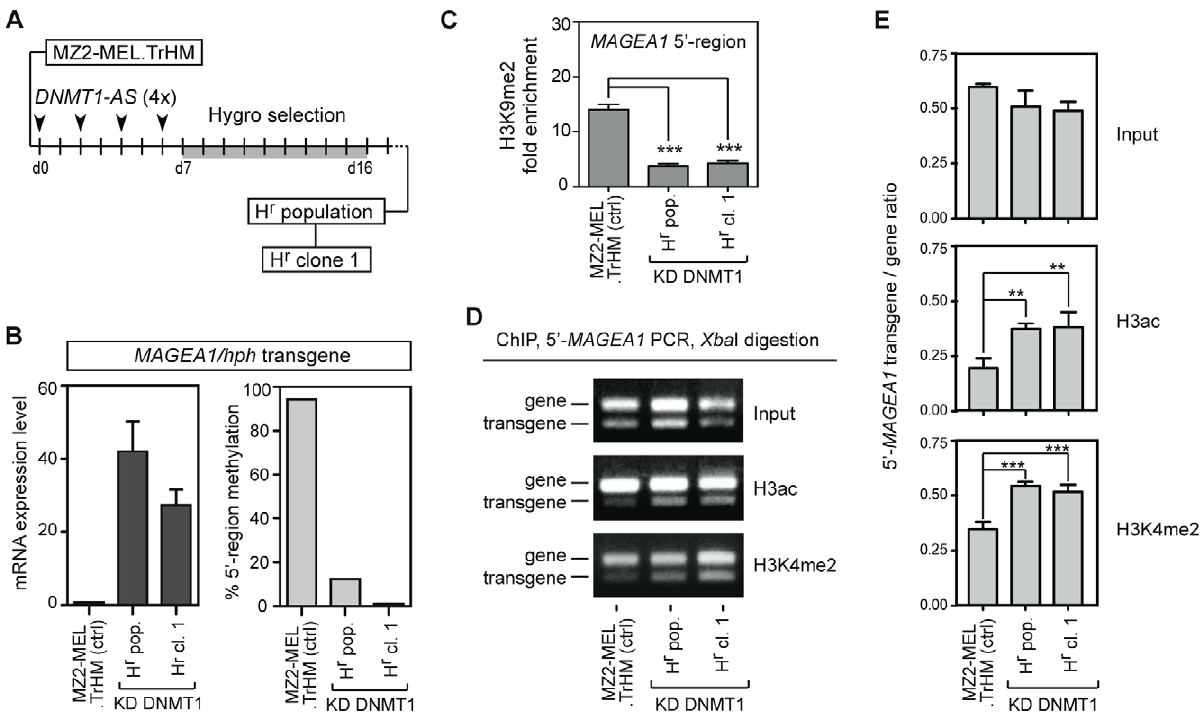
Figure 5. DNA demethylation induces reversal of histone marks in MAGEA1/hph . A , Schematic outline of the derivation of the H r population and H r clone 1 from MZ2-MEL.TrHM cells (see reference [24] for details). MZ2-MEL.TrHM cells were repeatedly tranfected with antisense oligonucleotides directed against DNMT1 ( DNMT1-AS ) during 7 days, and were thereafter transferred into medium containing hygromycin. After 9 days of hygromycin selection, a resistant population emerged (H r population), and a clone (H r clone 1) was isolated from this population by limiting dilution. The H r population and H r clone 1 were subsequently cultured without hygromycin selection. B , The mRNA expression level (ratio to 10 4 ACTINB ) and 5 9 -region DNA methylation status (% methylated CpGs) of the MAGEA1/hph transgene were determined in MZ2-MEL.TrHM cells, the H r population and H r clone 1 by qRT-PCR and bisulfite sequencing, respectively. C , ChIP-qPCR was used to evaluate enrichment of H3K9me2 within the MAGEA1/hph transgene in the three groups of cells (see text for details). Fold enrichment levels were obtained by reporting the MAGEA1 5 9 -region enrichment values to that of the GAPDH 5 9 -region in the same sample. Data represent the mean ( 6 sem) of two to three ChIP experiments, with two duplicate qPCR measurements in each case. *** P , 0.001. D , The ChIP/PCR/ Xba I procedure (see Fig. 3A, B) was applied to evaluate enrichment of H3ac and H3K4me2 within the 5 9 -region of the MAGEA1/hph transgene in the three group of cells. E , ImageJ analyses of gel electrophoresis pictures were used to quantify the MAGEA1 5 9 -region transgene/gene ratio. Data represent the mean ( 6 sem) of two independent ChIP experiments, with two PCR/ XbaI/electrophoresis analyses in each case. ** P , 0.01, *** P , 0.001.